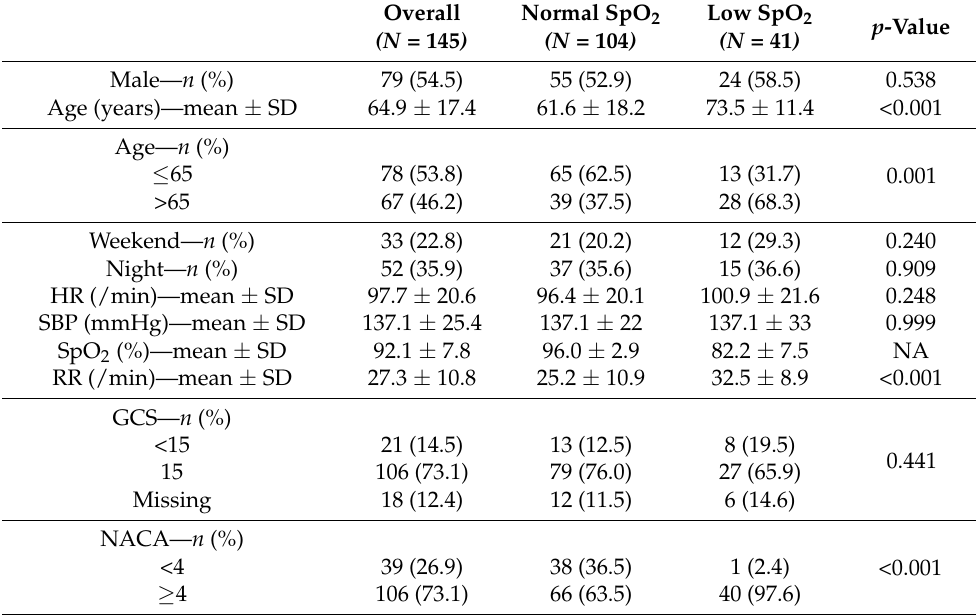
Table 1. Patient characteristics.